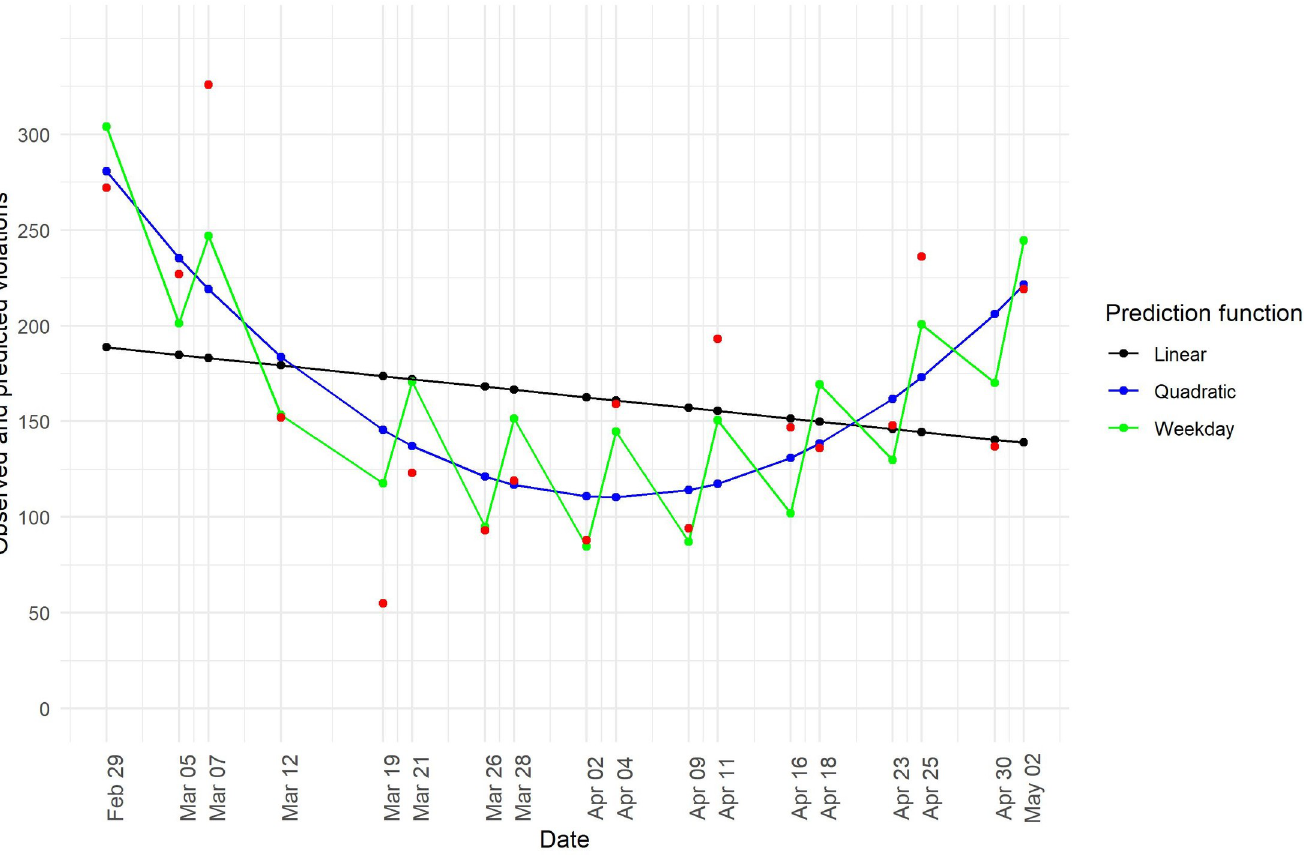
Fig 4. Social distancing violations as a function of time. Observed values (in red), and fitted values of a linear model (Model 1 in Table 1; in black), a quadratic model (Model 2 in Table 1; in blue), and a quadratic model that corrects for periodicity due to weekday (Model 3 in Table 1; in green).